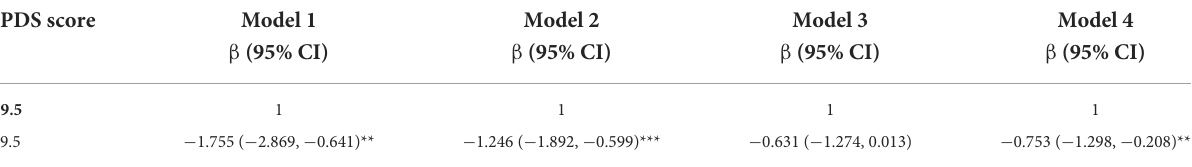
TABLE 3 Linear regression analysis for EPDS and WMS